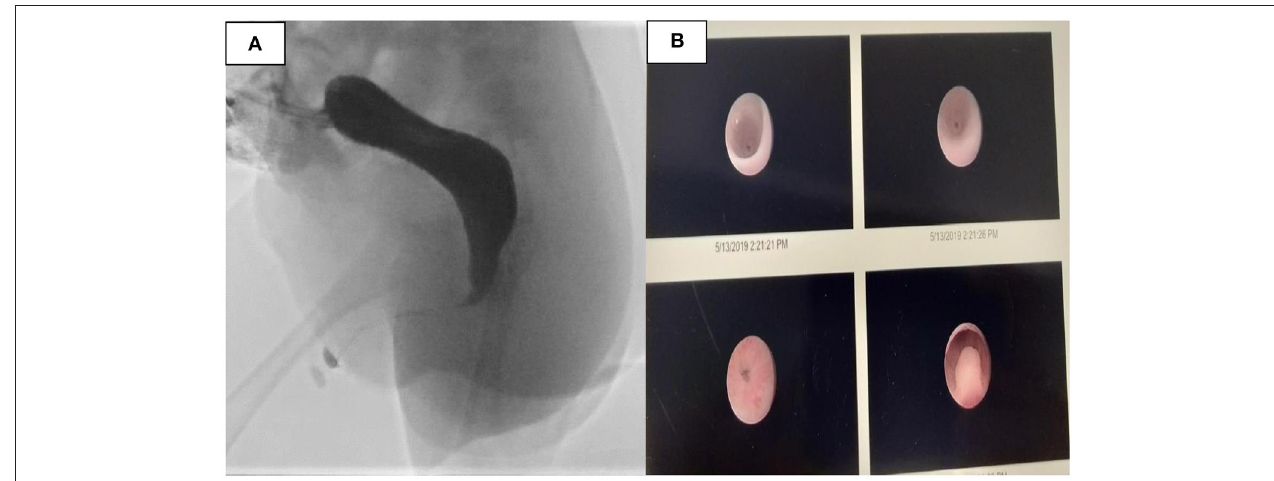
FIGURE 3 | Intraoperative photographs demonstrating that a 1-mm rectoperineal fistula was noted externally and cannulated with a microprobe. On mobilization of the rectum, the rectal stump was found to be at the level of the bulbous urethra. A common wall was identified between the bulbous urethra and the fistula tract extending for 3cm. The bulbous urethra was inadvertently laid open during separation of the common wall. Subsequently, urethroplasty was done in two layers, and anoplasty was completed.